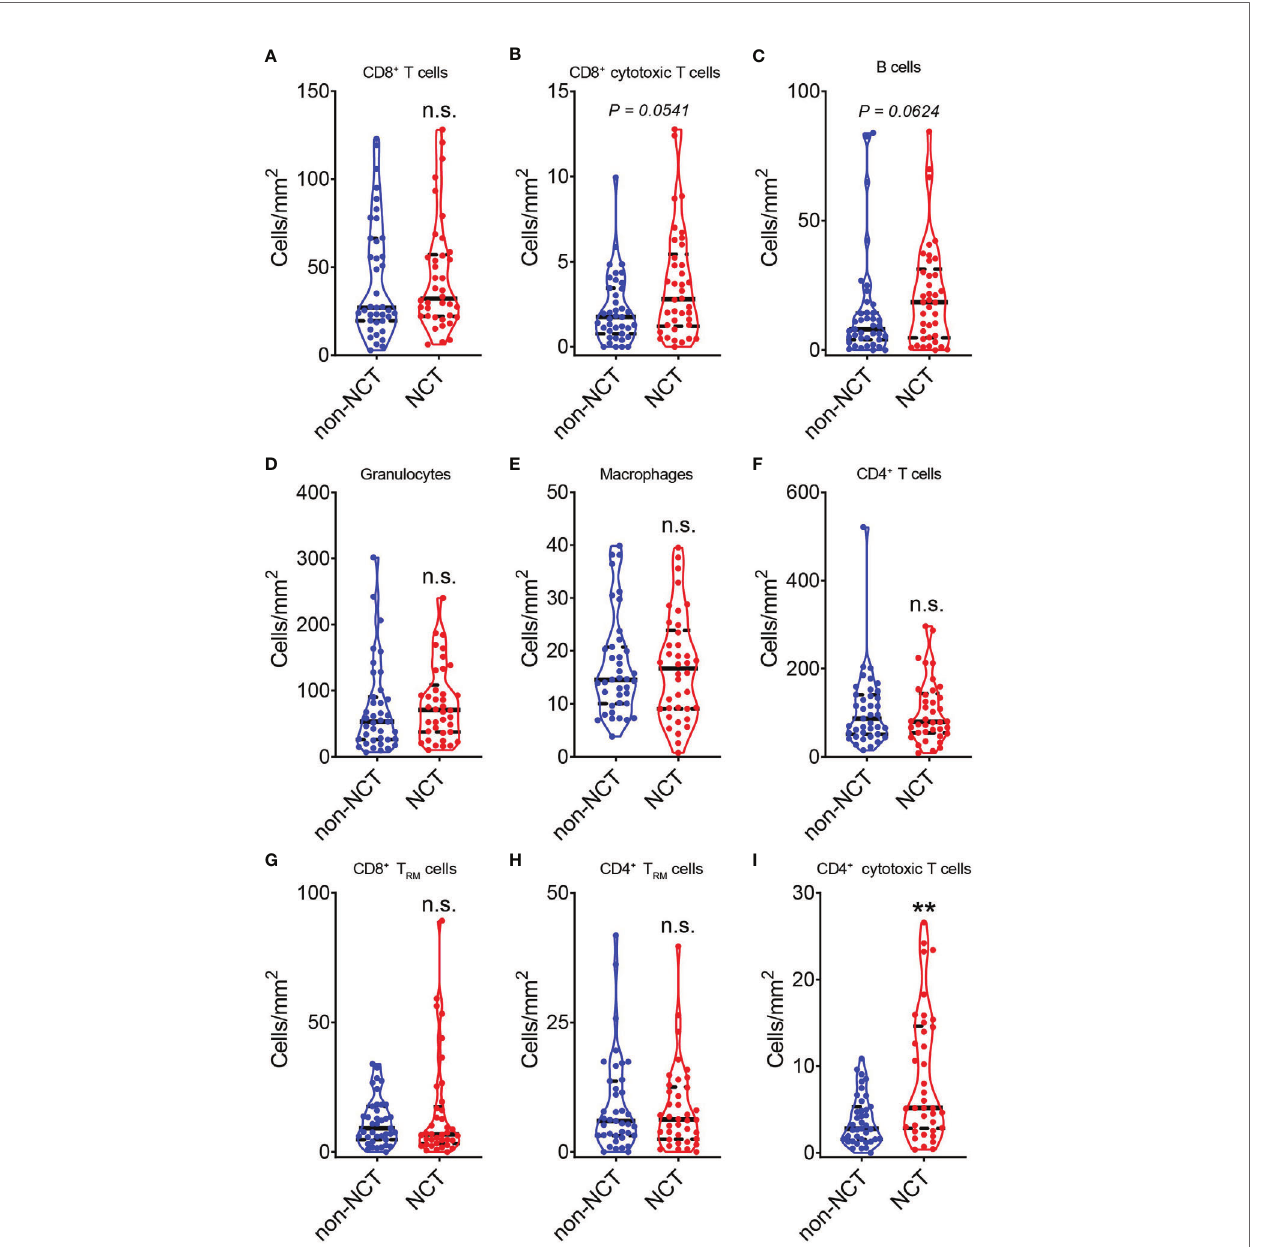
FIGURE 2 | Evaluation of the effect of neoadjuvant chemotherapy on the total TILs in pMMR CRC. The violin plots displayed the alterations in CD8 + T cells (A) , CD8 + GzmB + T cells (B) , CD20 + B cells (C) , CD66b + granulocytes (D) , CD68 + macrophages (E) , CD4 + T cells (F) , CD8 + T RM cells (G) , CD4 + T RM cells (H) and CD4 + GzmB + T cells (I) during neoadjuvant chemotherapy (NCT). The thick dashed lines and thin dotted lines denote the median and interquartile range, respectively. Statistical signi fi cances were determined via Mann-Whitney tests, with ** P < 0.01, n.s. not signi fi